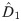
Spectral distance contrast D^1—For the three matrices: Adjacency, combinatorial Laplacian, and normalized Laplacian (from left to right)—Between the preferential attachment and the uncorrelated random graph model (null model).